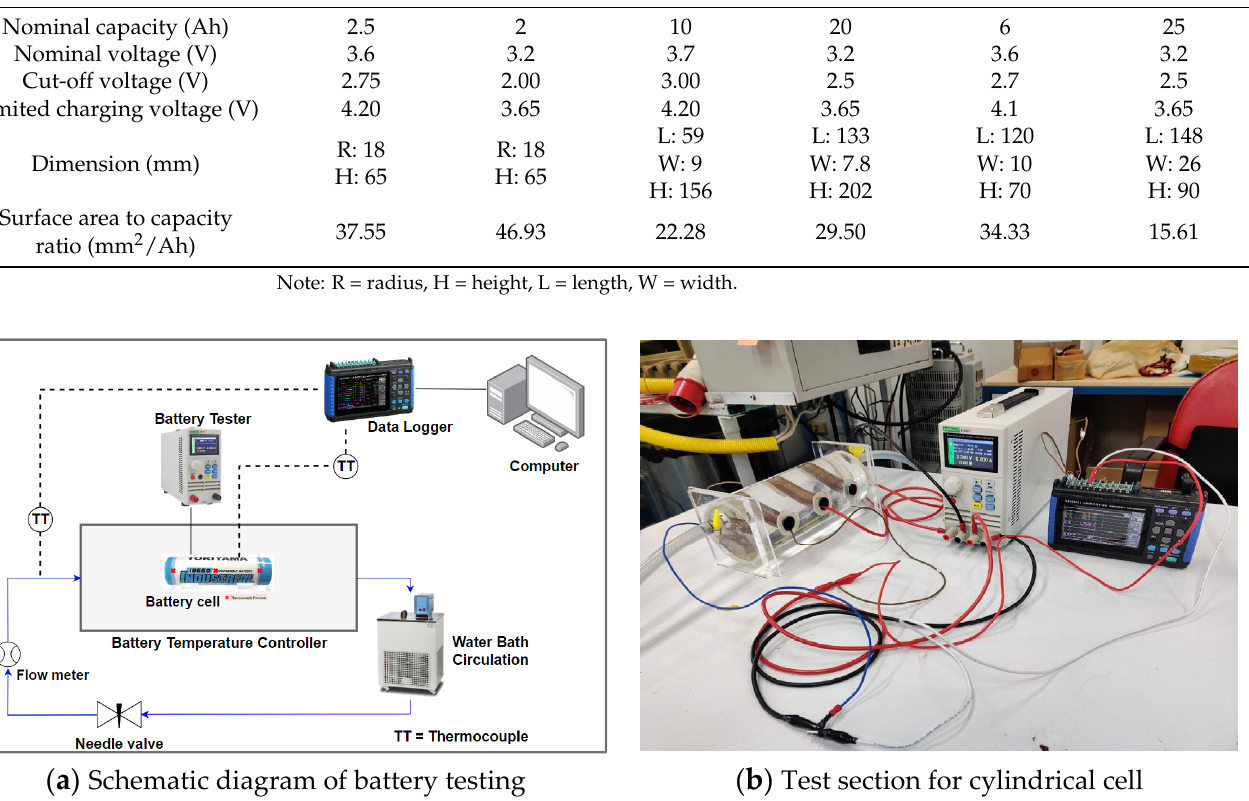
Figure 2. Experimental setup ( a ) schematic diagram of battery testing, and ( b ) test section for cylindrical cell.